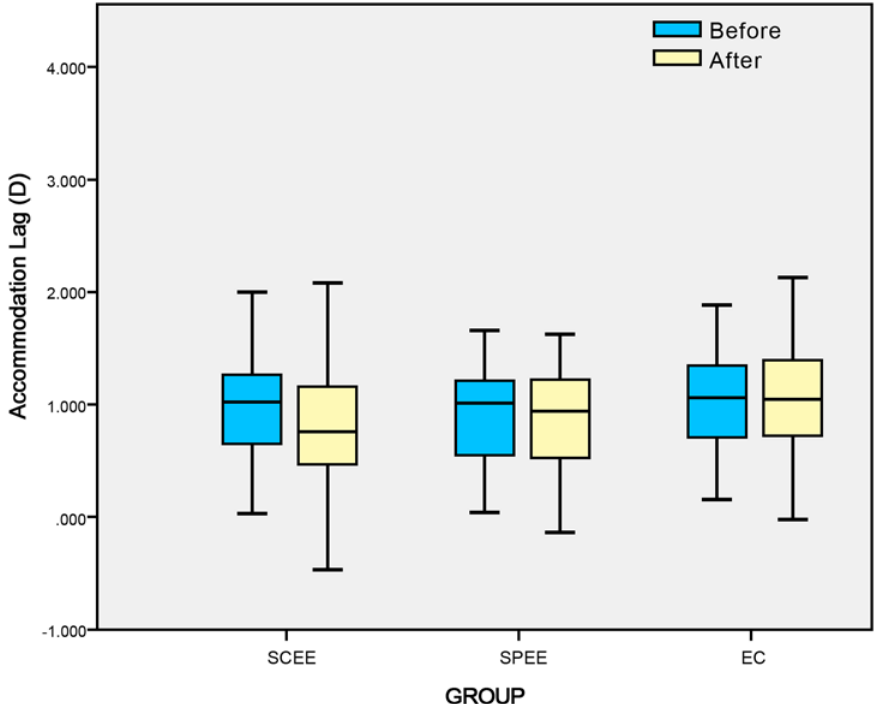
Fig 3. Distribution and mean of accommodative lag before and after intervention.